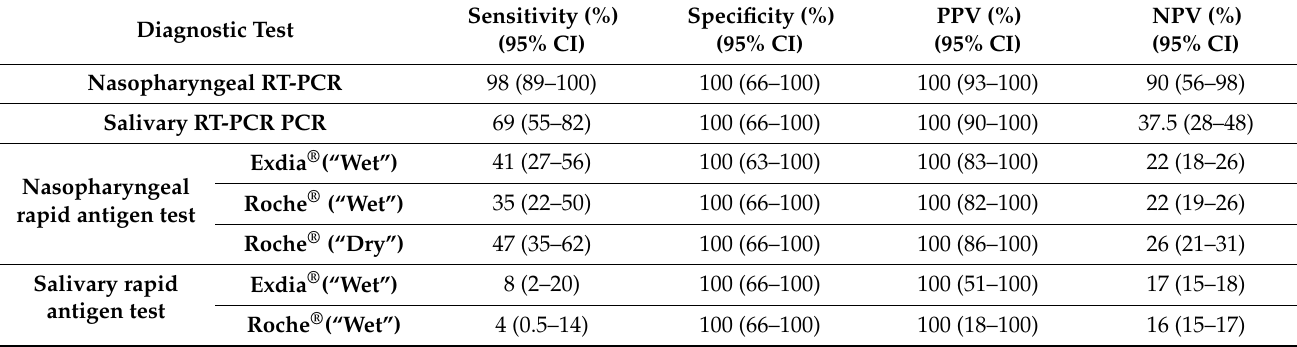
Table 2. Overall diagnostic performance metrics of the different diagnostic approaches